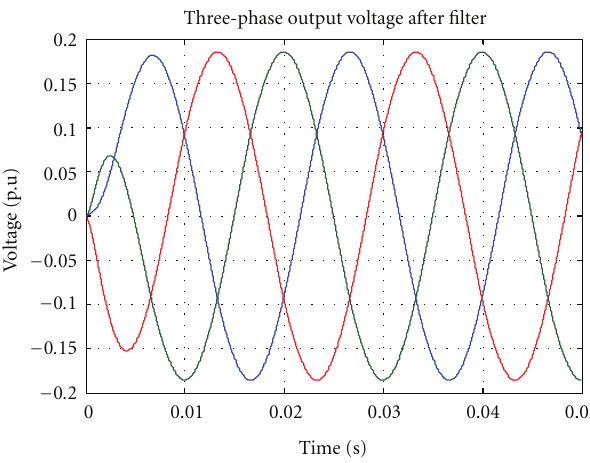
Figure 11: Load current of phase